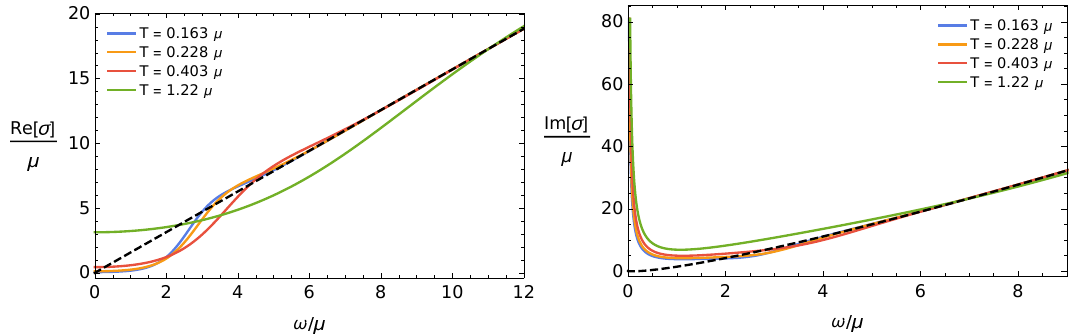
Figure 13. Real (left) and imaginary (right) part of the optical conductivity for the Reissner- Nordstr(cid:127)om metal in d = 3 + 1 for di(cid:11)erent values of the temperature. The black dashed line is the AdS 5 analytical solution. For large frequency we see that both the real and the imaginary parts go to the AdS 5 results, where for the imaginary part we choose the cuto(cid:11) scale ! uv to be the same for di(cid:11)erent values of T=(cid:22) . In particular, in the imaginary part, we can observe the logarithmic behavior for large frequency, as well as the 1 =! behavior for small ! . This implies that the real part of the conductivity contains a delta function Z(cid:14) ( ! ), with Z the Drude weight that in this case is given by Z = 2 h (cid:26) i 2 = 3 h (cid:15) i